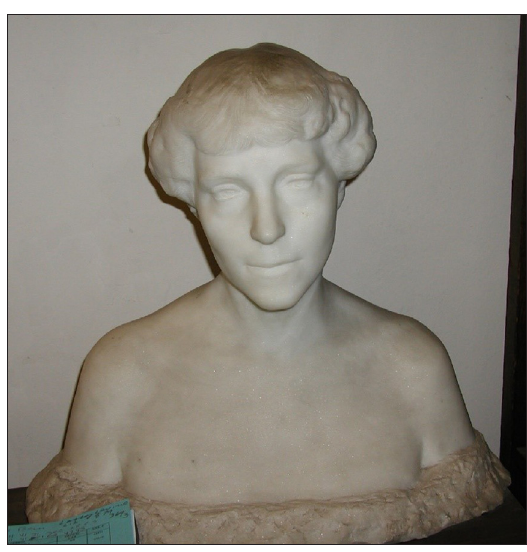
Fig. 10 : Paul M. Landowski, Portrait Bust of Florence Blumenthal (1873–1930) , 1923, Carrara marble, 45.7 × 48.2 × 24.8 cm, Art Properties, Avery Architectural and Fine Arts Library, Columbia University (inv. 1968.10). Photograph by the author, courtesy of Avery Architectural and Fine Arts Library, Columbia